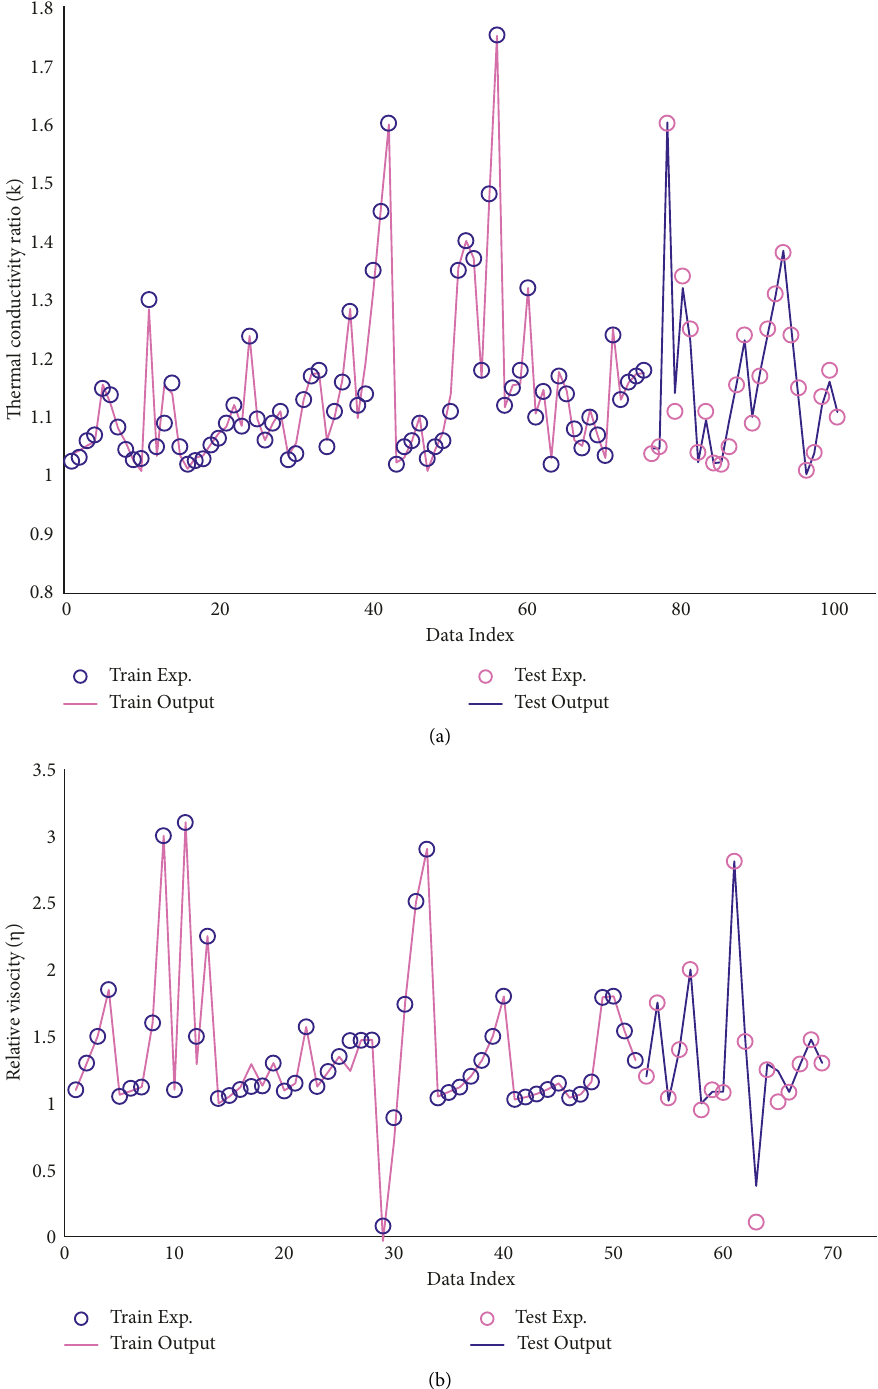
Figure 3: Simultaneous viewing of laboratory and modeled data of the (a) TC ratio and (b) relative viscosity of NFs related to training and testing